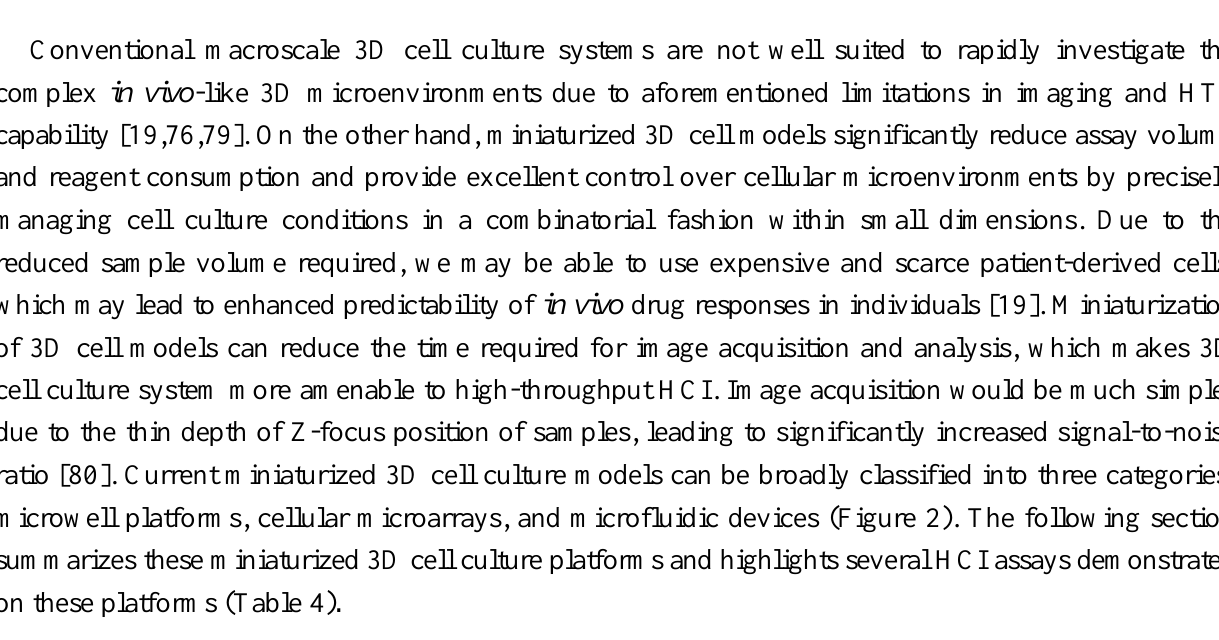
Table 4. Advantages and disadvantages of miniaturized 3D cell-based assay